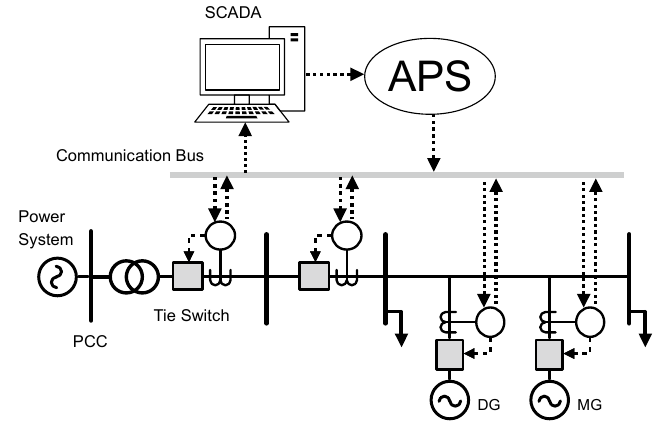
Figure 1. Architecture of the proposed APS.